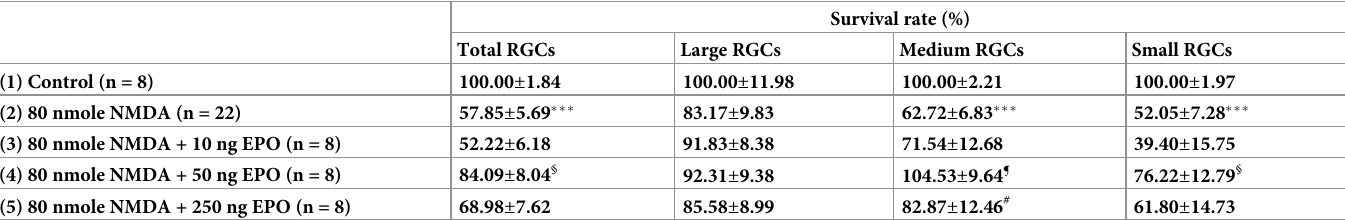
Table 1. The survival rates of large, medium, and small RGCs was evaluated for different EPO’s dose by retinal flat mount analysis: The survival rates of RGCs were determined as groups (1) Control, (2) NMDA-mediated (80 nmoles NMDA), and (3–5) EPO-treated groups (80 nmoles NMDA + 10, 50, 250 ng